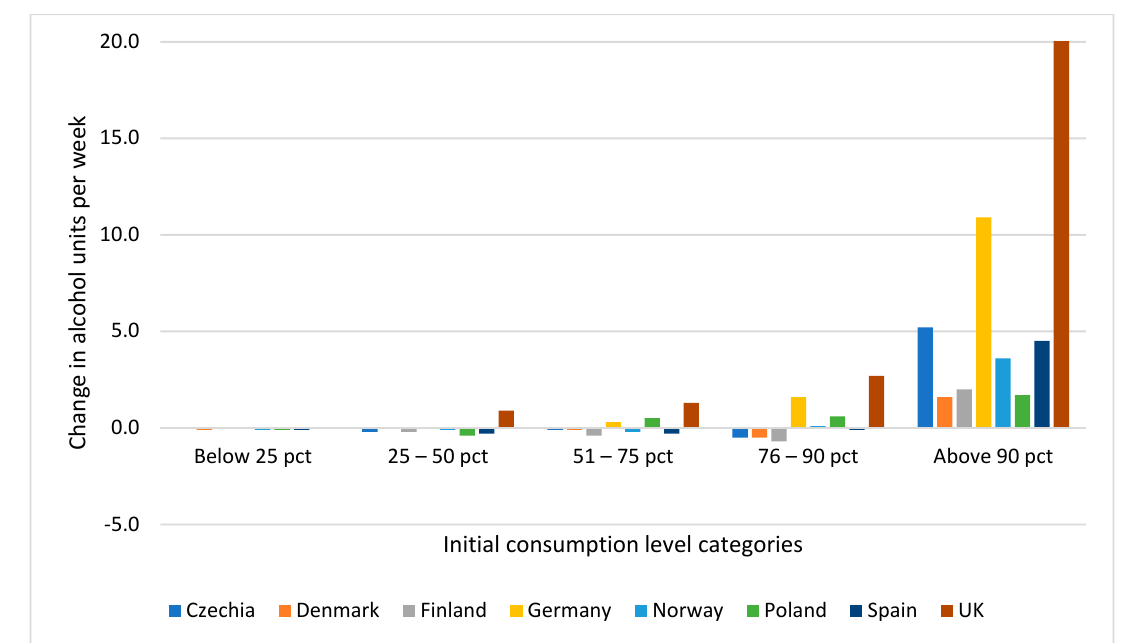
Figure 1. Change in estimated volume of consumption by initial consumption level and country. Note: Initial consumption level categories are based on percentiles of the distribution in each country.